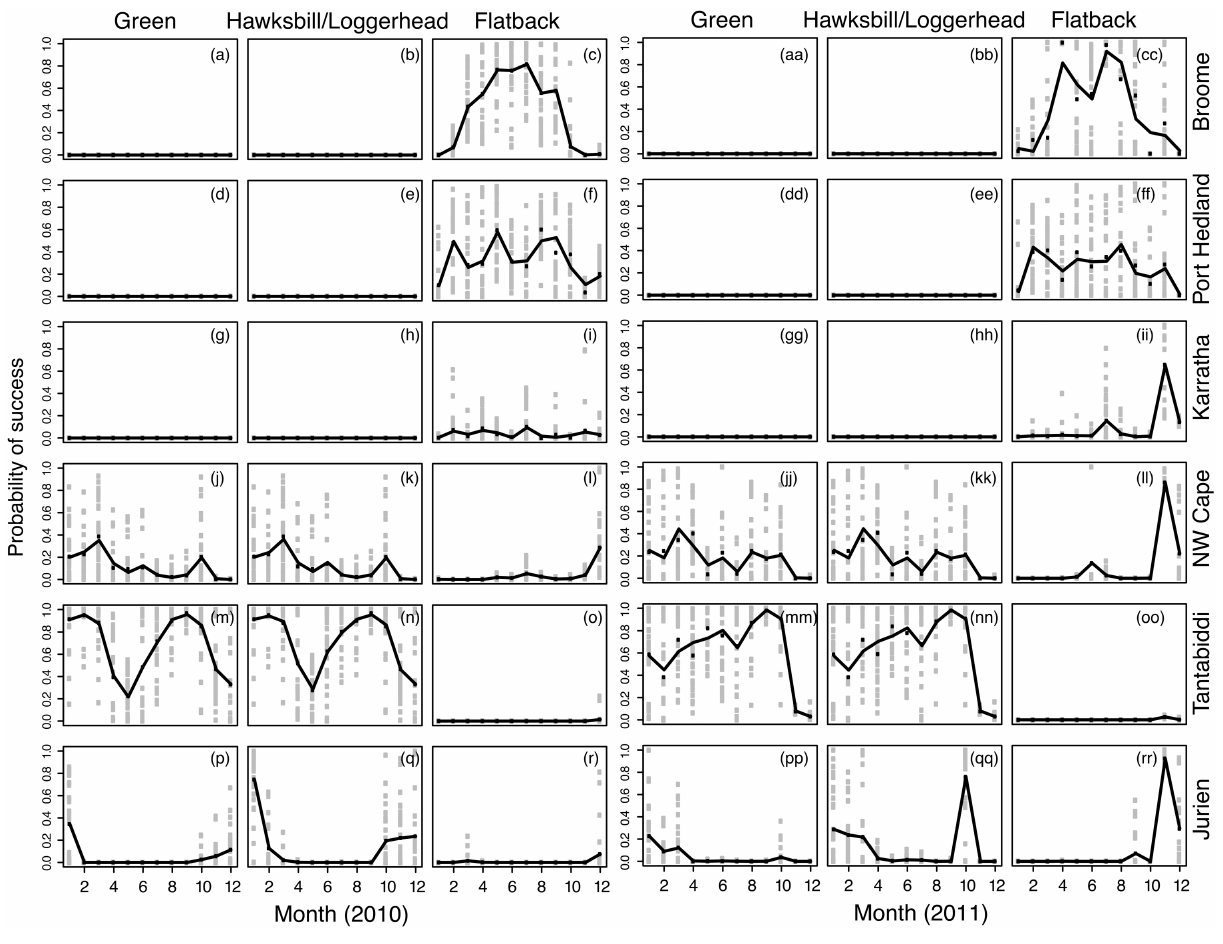
the 60 day drift duration prescribed to the particles ( Figure 4